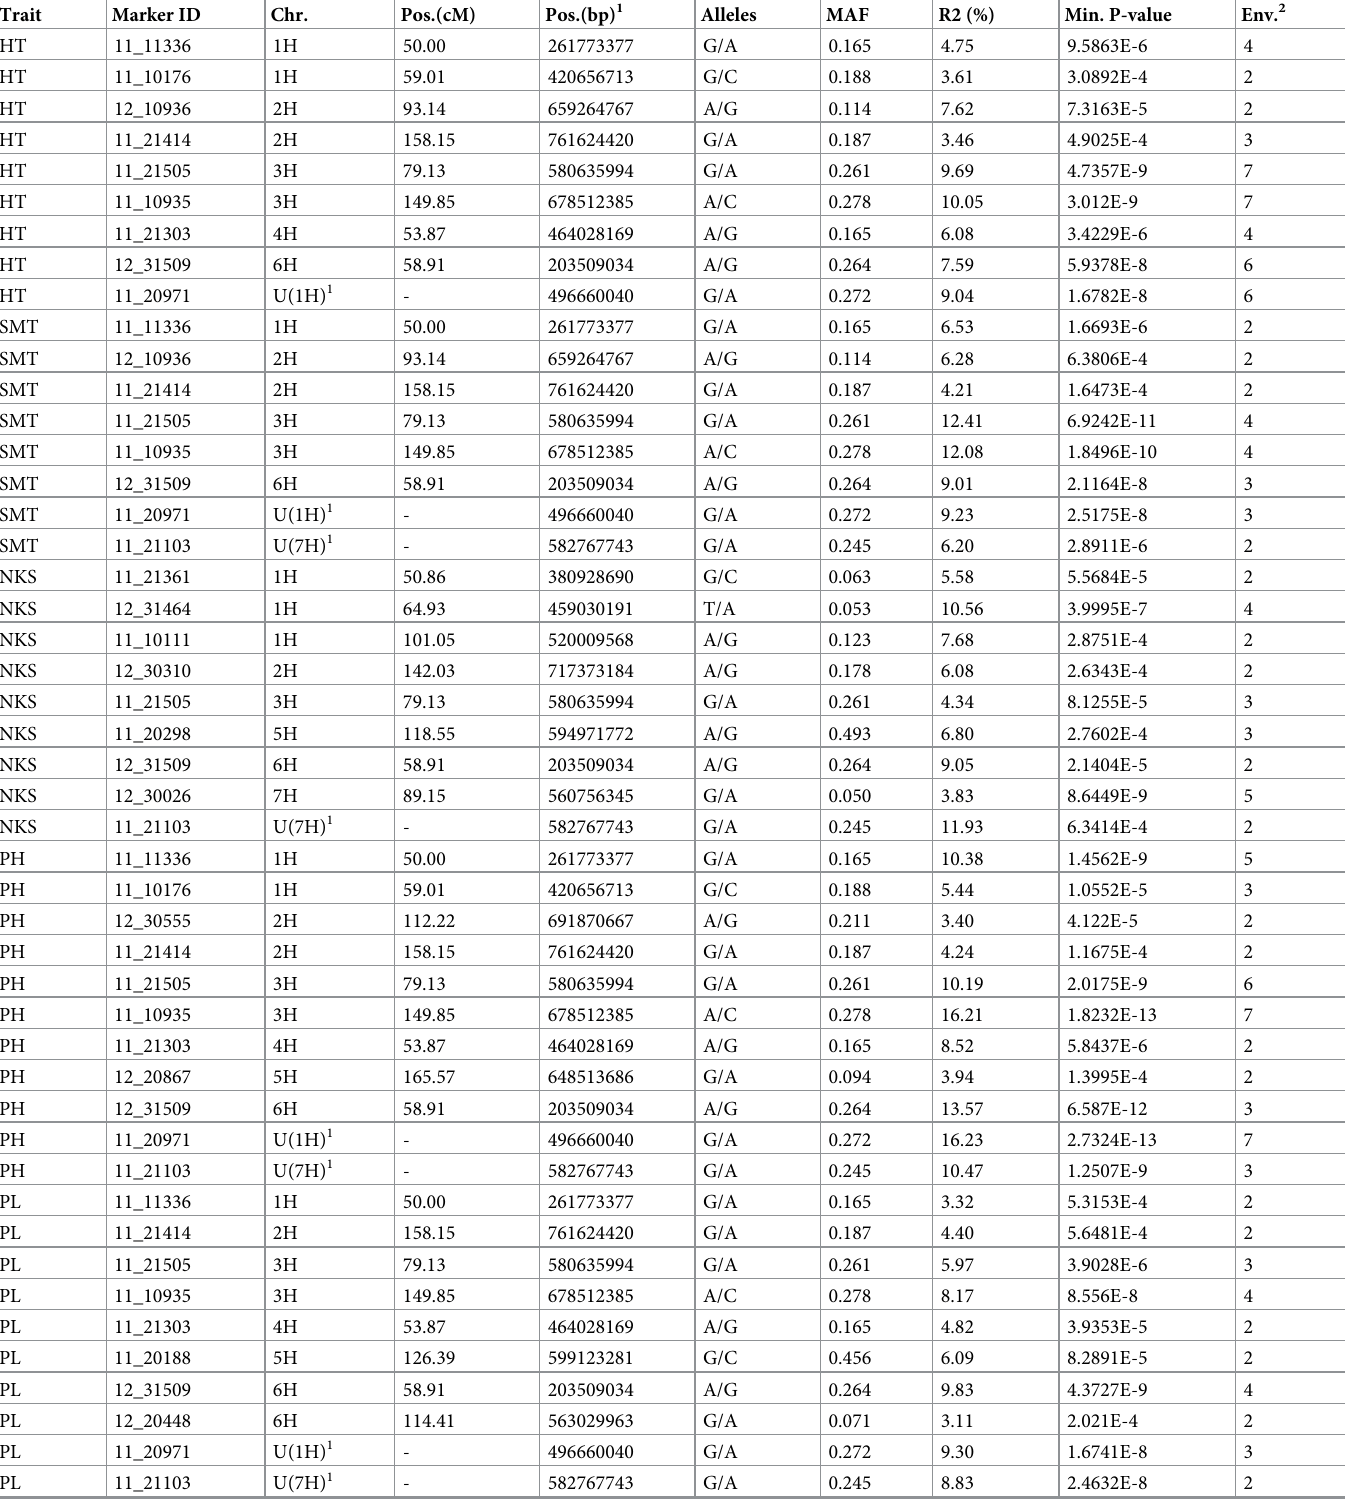
Table 3. The list of MTA identified for nine traits scored at six different stations in Kazakhstan, 2009–2011. Trait Marker ID